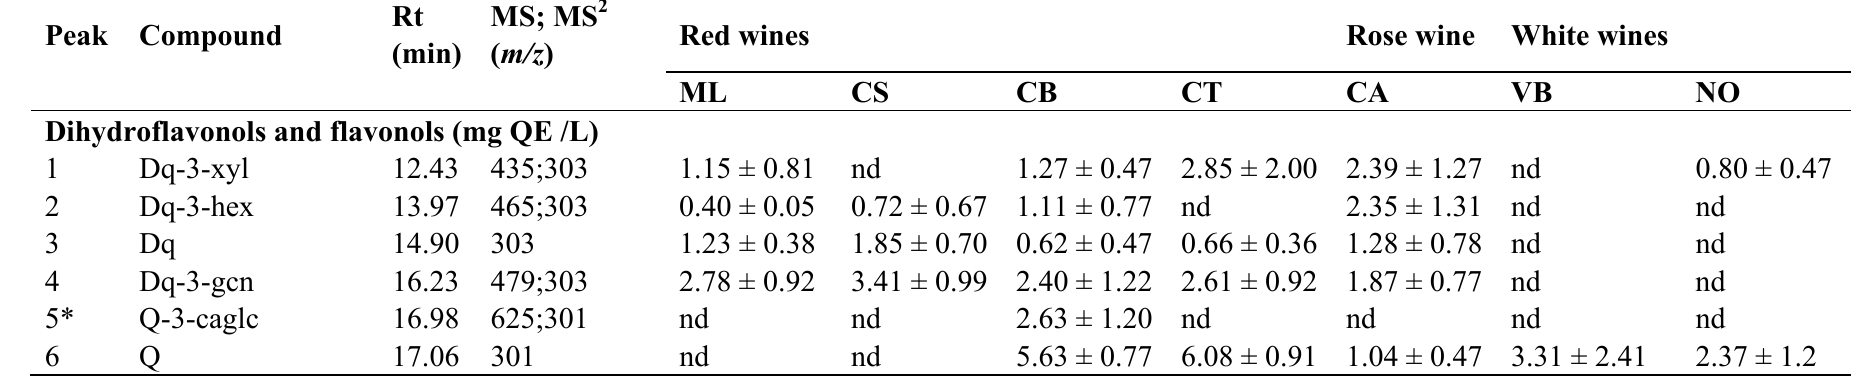
Table 4. Retention times, ESI-MS/MS m/z values (molecular ion (MS); product ions (MS 2 )) and concentrations of individual non-anthocyanin phenolic compounds identified in the wines from different grape